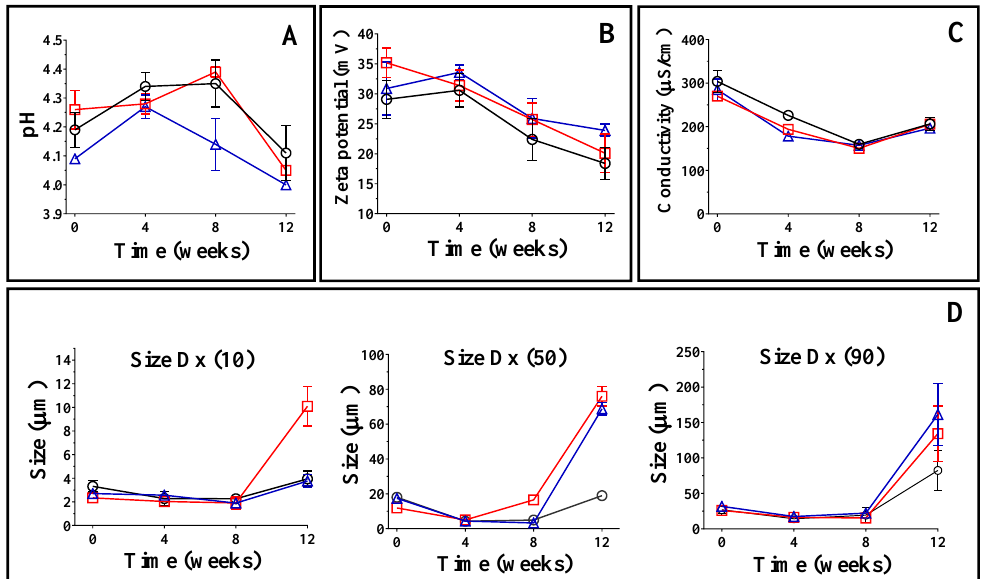
Figure 5. Results of ( A ) pH, ( B ) electrical conductivity, ( C ) zeta potential, and ( D ) particle size distribution for the selected prototypes as a function of time. HBD-Cl + CT-Cl (3:1), BT-MS + CT-Cl (1:3), ∆ BT-MS + CT-Cl (1:3), BT-MS + CT-Cl (3:1).